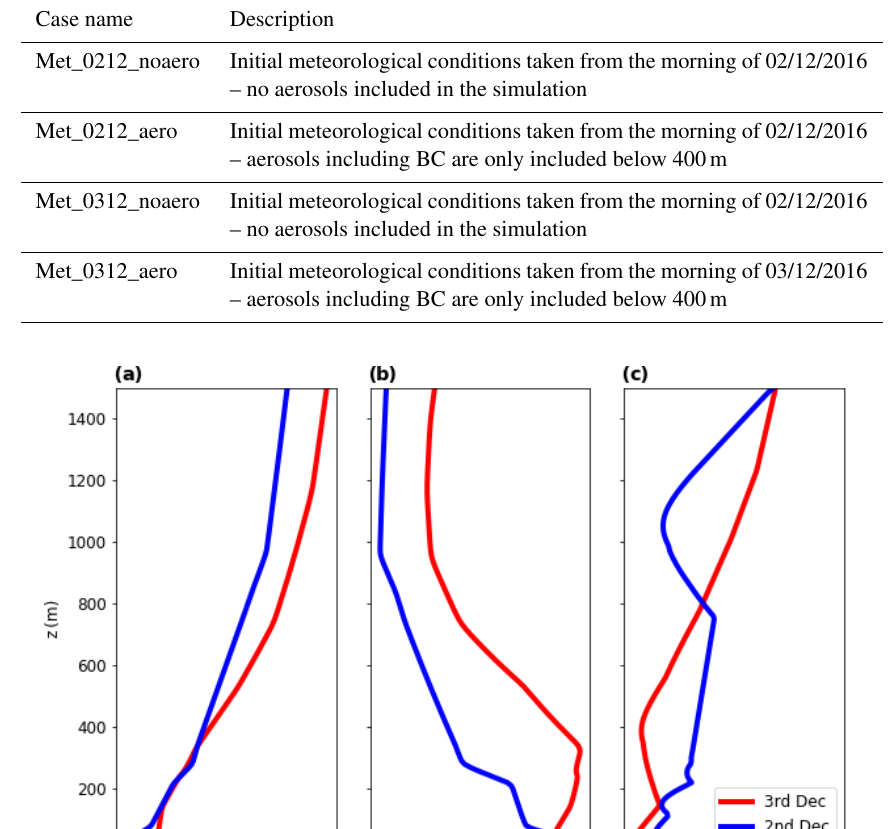
Table 4. Table detailing the outline of each of the four simulations for the second case study focusing on the impact of initial meteorological conditions (Case Met).